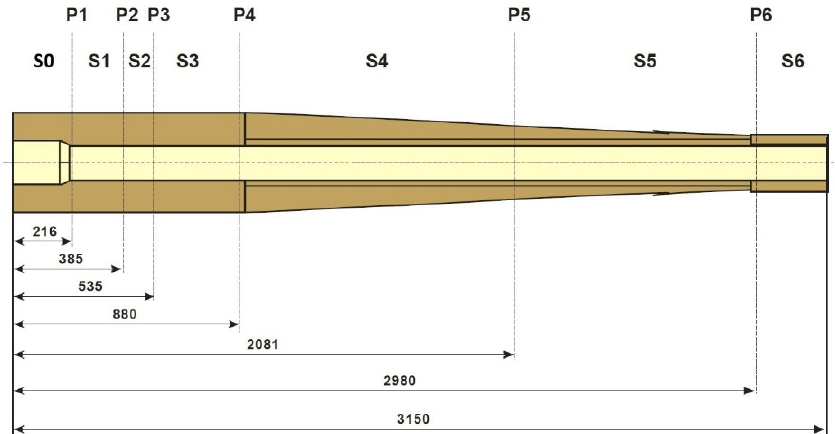
Figure 1. Heat transfer zones S1 to S6 of the 35 mm cannon barrel input to the calculations: S1: 0 ÷ 385 mm, r out = 55.0 ÷ 55.0 mm; S2: 385 ÷ 535 mm, r out = 55.0 ÷ 57.0 mm; S3: 535 ÷ 880 mm, r out = 57.0 ÷ 59.5 mm; S4: 880 ÷ 2081 mm, r out = 59.5 ÷ 44.07 mm; S5: 2081 ÷ 2980 mm, r out = 44.07 ÷ 31.0 mm; S6: 2980 ÷ 3150 mm, r out = 31.0 mm. The zone S1 includes the zone S0 of the cannon breech (reproduced with permission from [24], Military University of Technology, 2022).